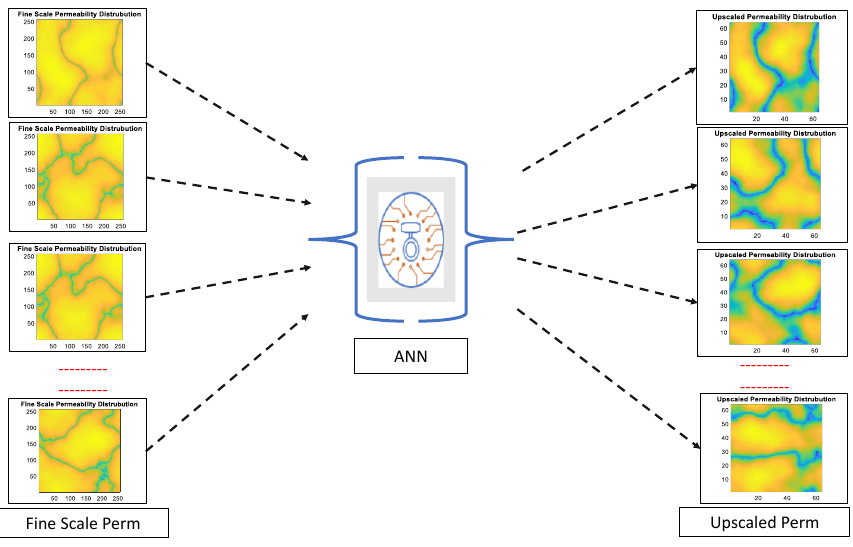
Figure 6. A conceptual plot of the neural upscaling workflow.